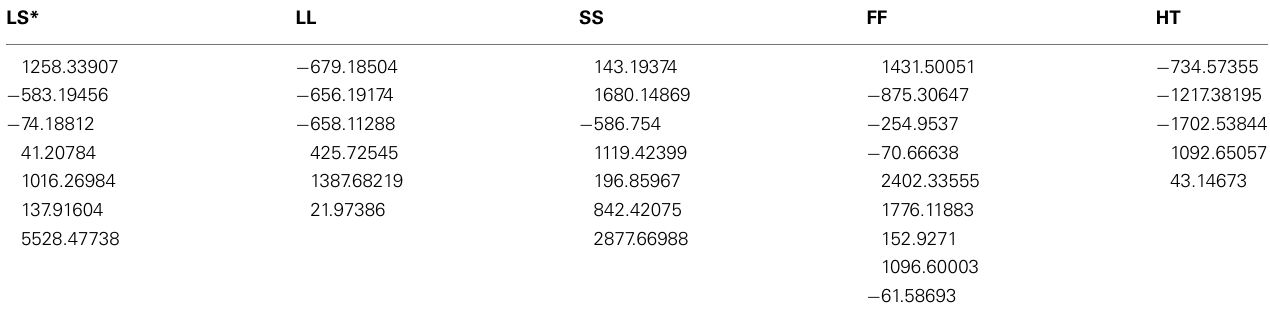
TableA3 | Pre-testing circulating E2